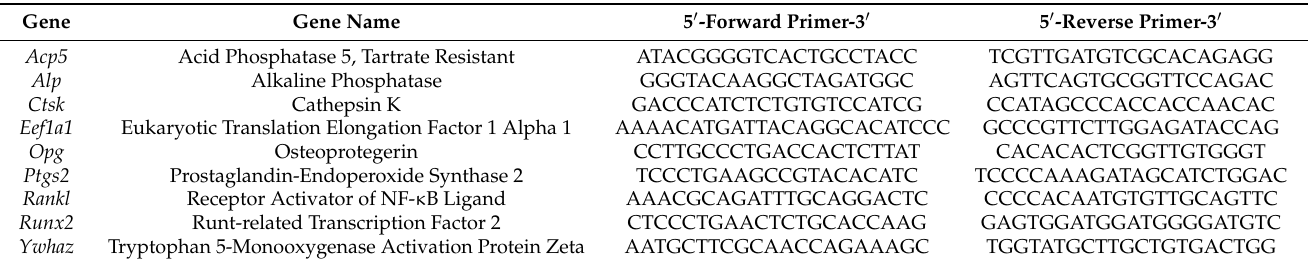
Table 1. Primers for reference ( Eef1a1/Ywhaz ) and target genes used in